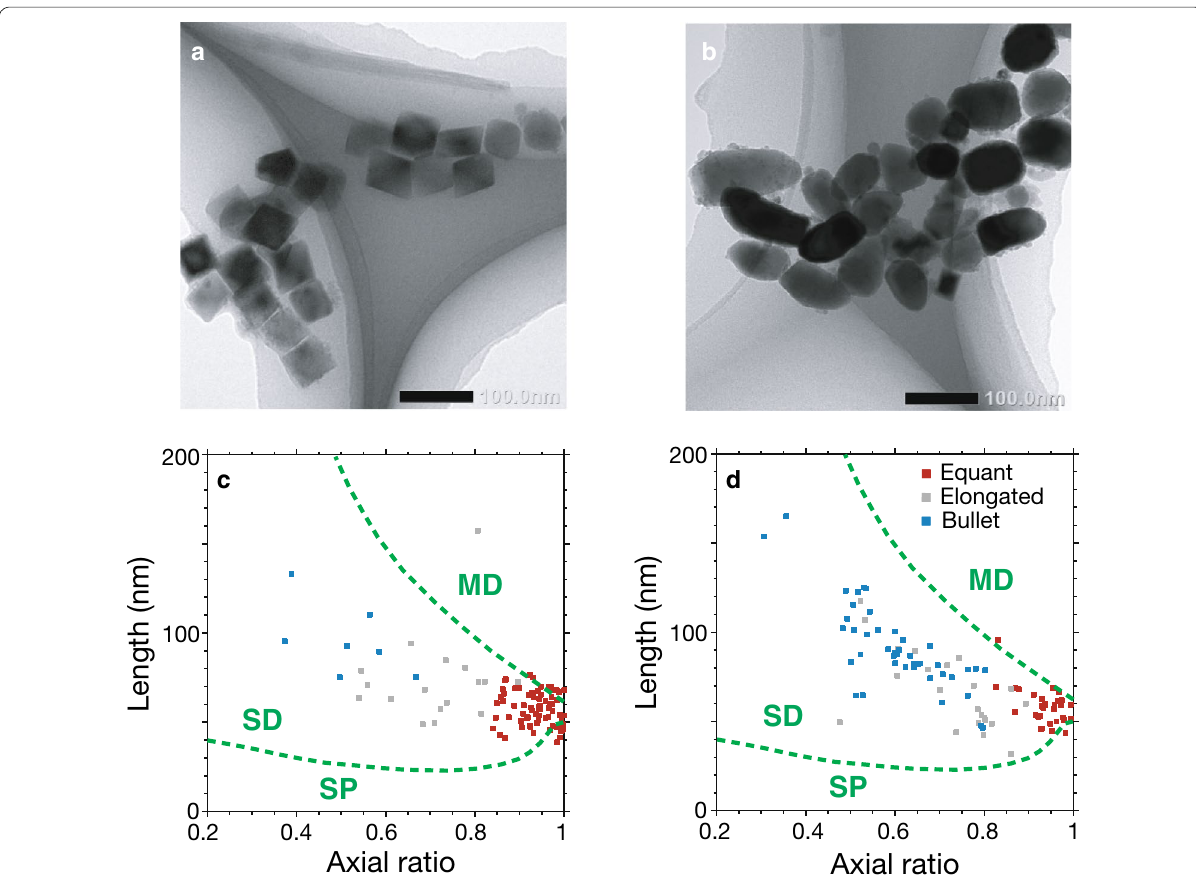
Fig. 6 Morphology of magnetofossils in core KR13-02 PC06. a , b TEM images of magnetic extracts from ( a ) 6.52 m and ( b ) 7.49 m. Scale bar: 100 nm. c , d Lengths and axial ratios of magnetofossils measured from TEM images at ( c ) 6.52 m and ( d ) 7.49 m. Magnetofossil morphology is classified into equant (red), elongated (gray), and bullet shaped (blue). SP, SD, and MD regions are after Tauxe et al.